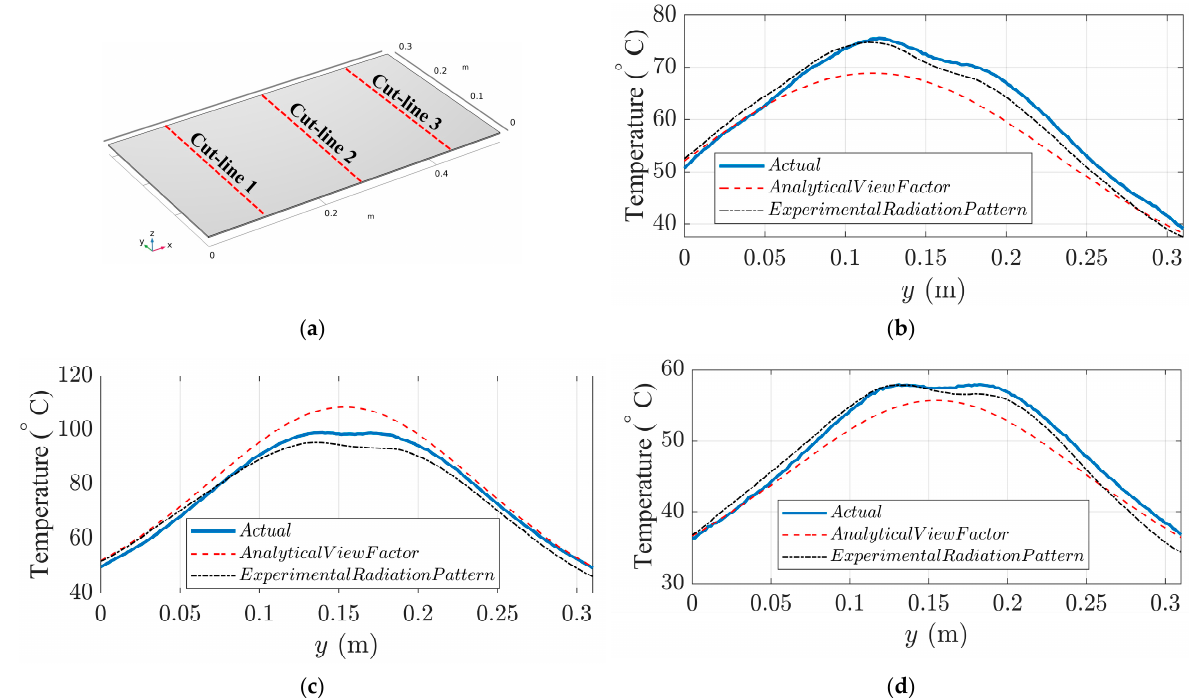
Figure 13. Actual and simulated temperature variations along three cut-line in the y direction of the thermoplastic sheet, ( a ) cut-line locations; ( b ) cut-line 1 temperatures; ( c ) cut-line 2 temperatures; ( d ) cut-line 3 temperatures.